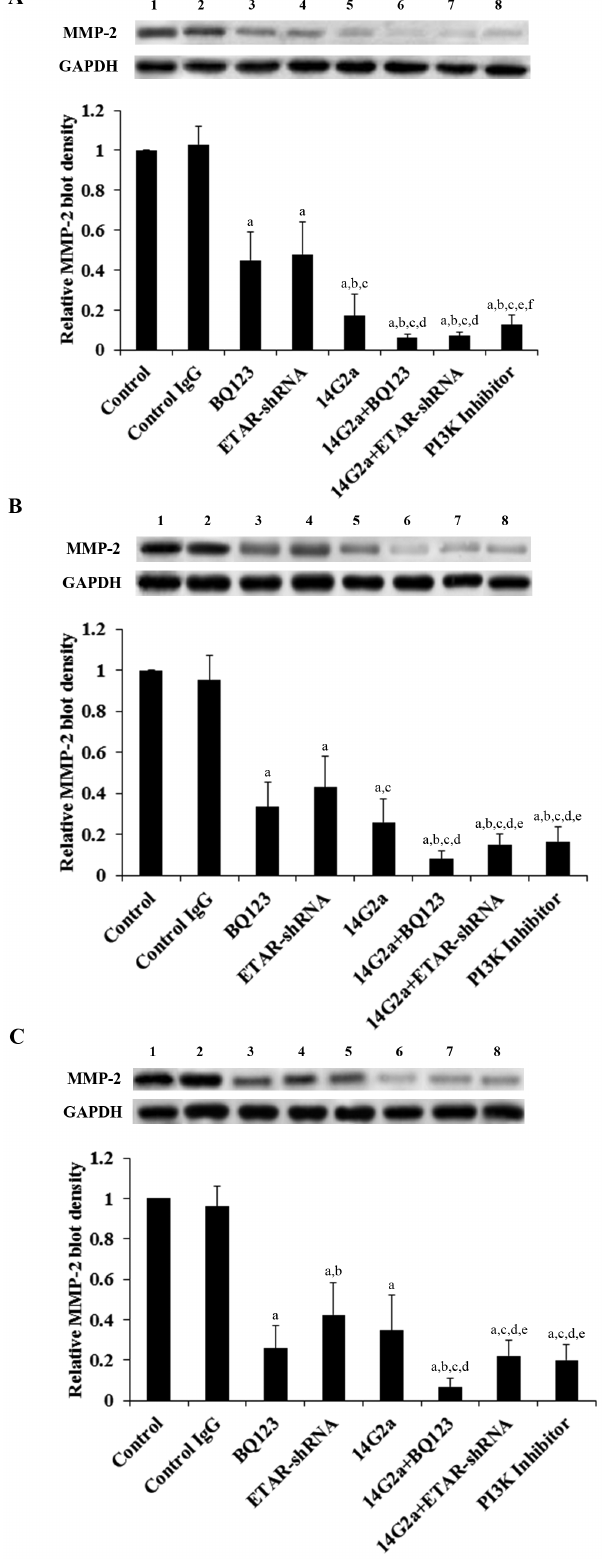
Figure 4. Effects of anti-ganglioside GD2 14G2a monoclonal antibody (mAb) alone or in combination with ET A receptor (ETAR) antagonist on matrix metalloproteinase-2